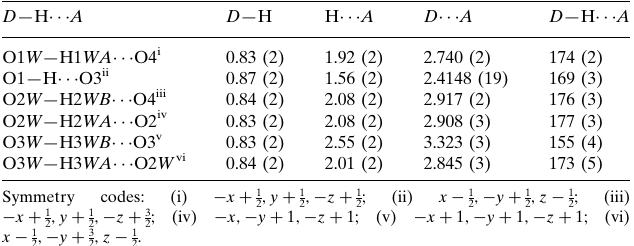
Hydrogen-bond geometry (A˚ , (cid:4)